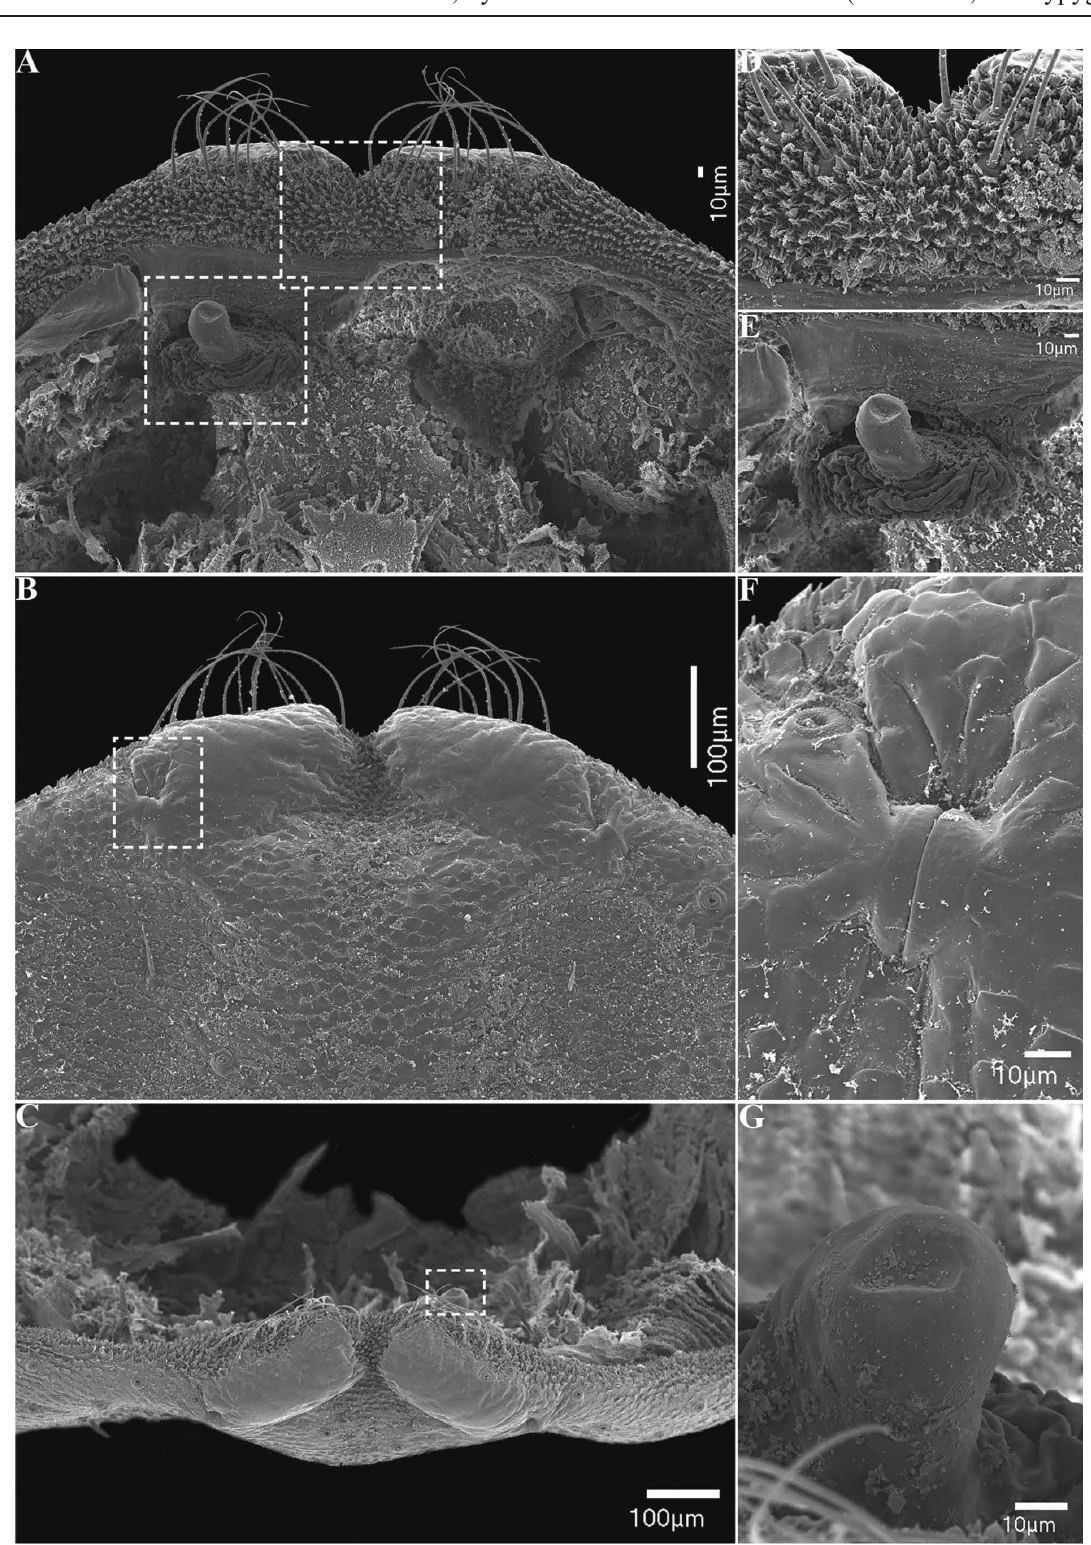
Fig. 127. Sarax tiomanensis sp. nov. (AMCC [LP 11998]), female gonopod and genital operculum. A . Finger-like gonopod, dorsal view. B . Posterior margin of genital operculum, ventral view. C . Gonopods, posterior view. D . Genital operculum between gonopods. E . Glandular openings inside gonopod projection. F .